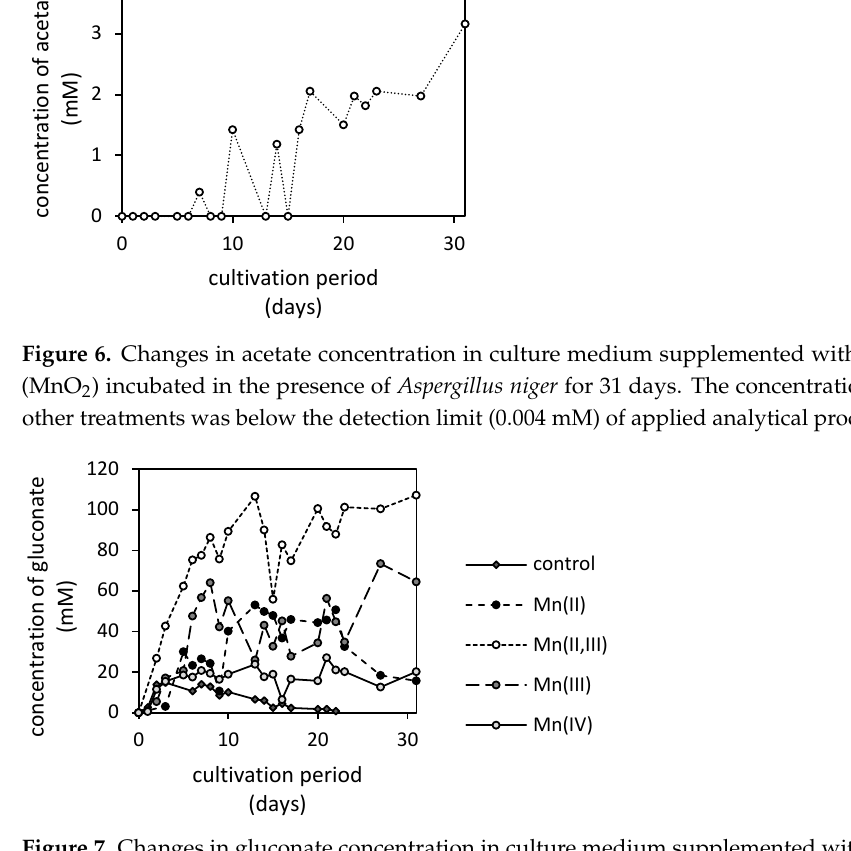
Figure 7. Changes in gluconate concentration in culture medium supplemented with various man- ganese oxides (MnO, MnO · Mn 2 O 3 , Mn 2 O 3 and MnO 2 ) incubated in the presence of Aspergillus niger for 31 days (control is a manganese-free treatment).